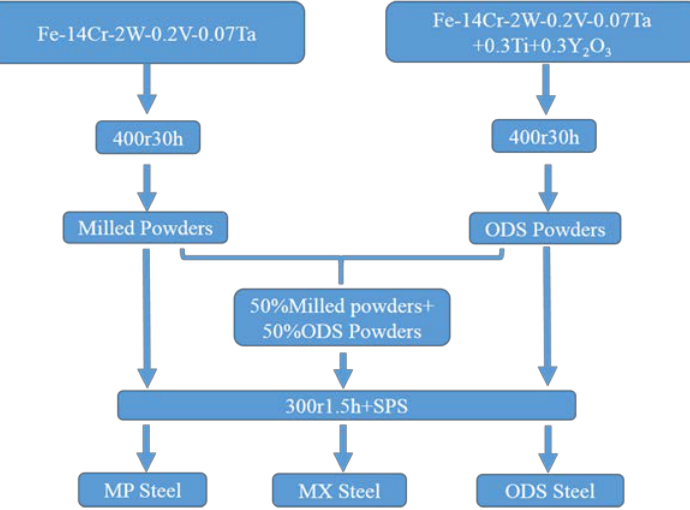
Figure 1. Schematic graph of the experimental procedures. Three model powders defined as MP powders (milled pre-alloyed powders), MX powders (50 wt.% MP powders + 50 wt.% (oxide dispersion strengthened) ODS powders) and ODS powders (alloyed pre-alloyed powders with the addition of Ti and Y 2 O 3 ). SPS: spark plasma sintering.